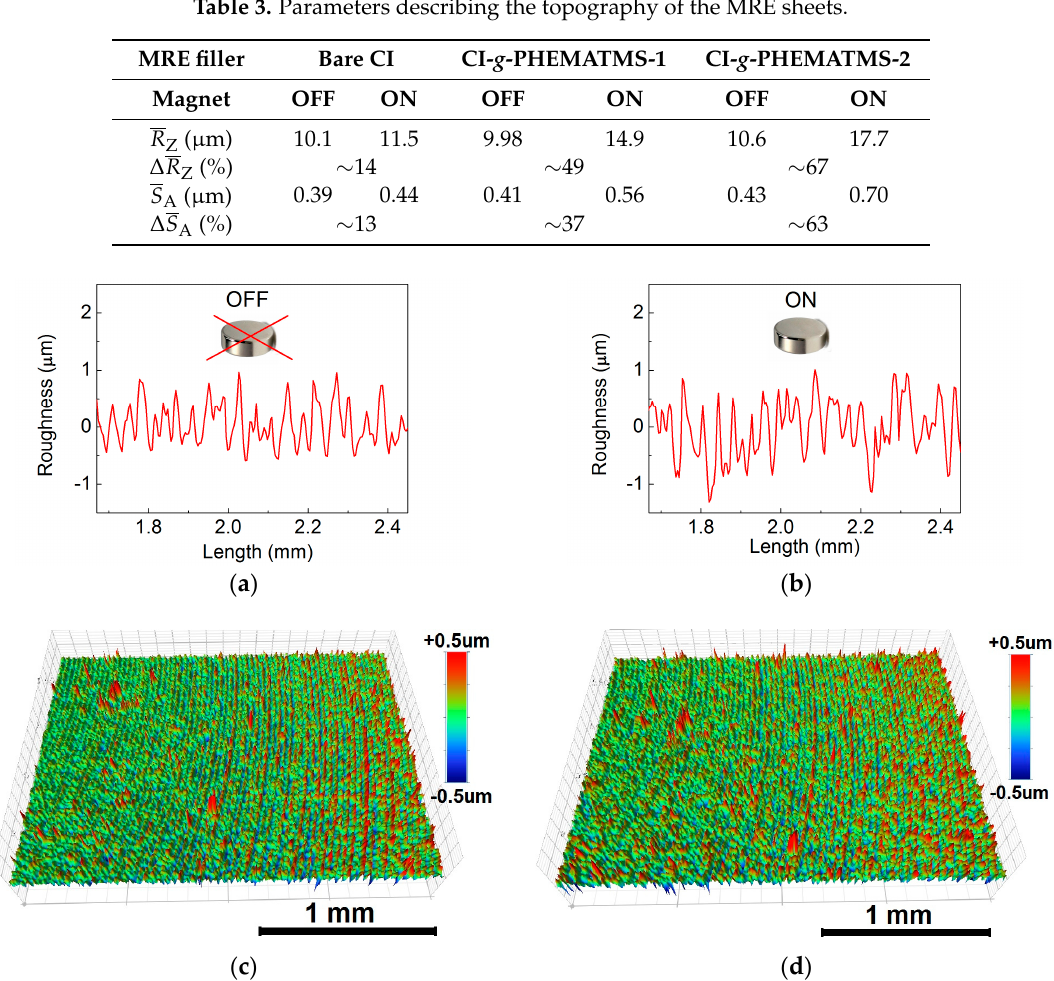
Table 3. Parameters describing the topography of the MRE sheets.